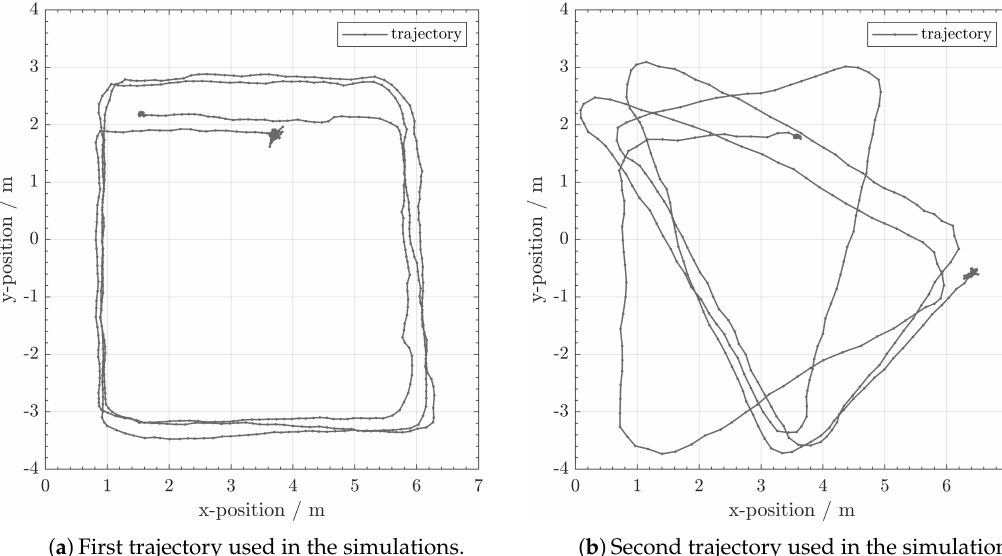
Figure 13. The two trajectories shown in ( a ) and ( b ) respectively are used in the simulations to emulate a moving